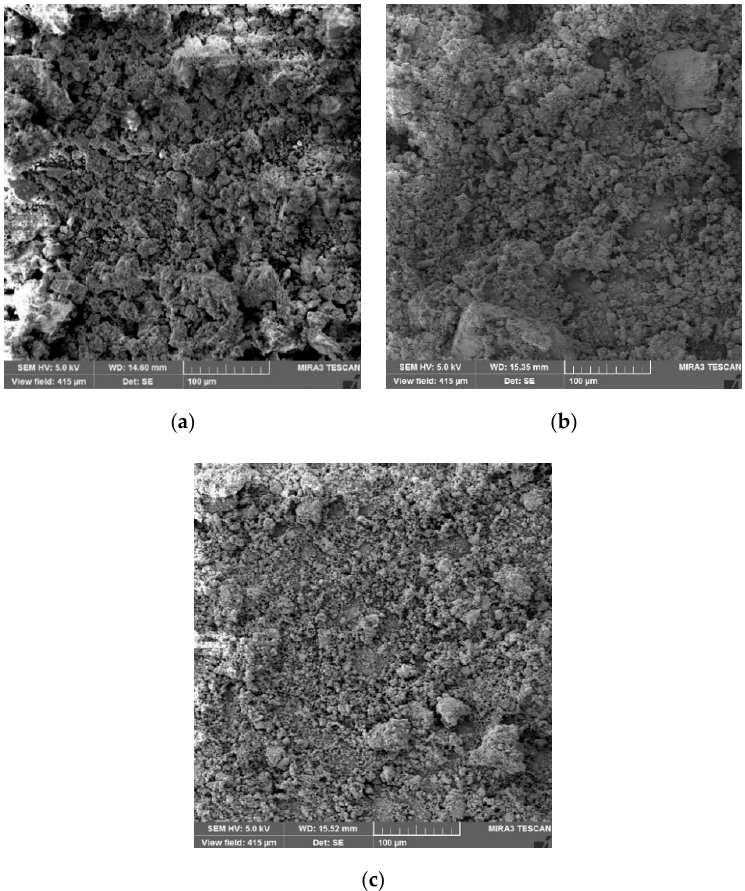
Figure 5. SEM images of C1 ( a ), C2 ( b ) and C3 ( c ) calcined at 550 °C (view at 500×).